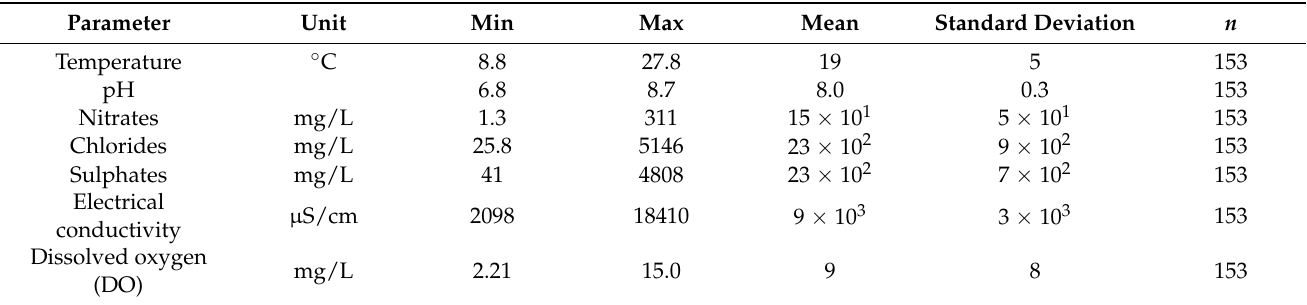
Table 1. Physicochemical variables available to develop the theoretical models, at the mouth of El Albuj ó n watercourse, between January 2014 and January